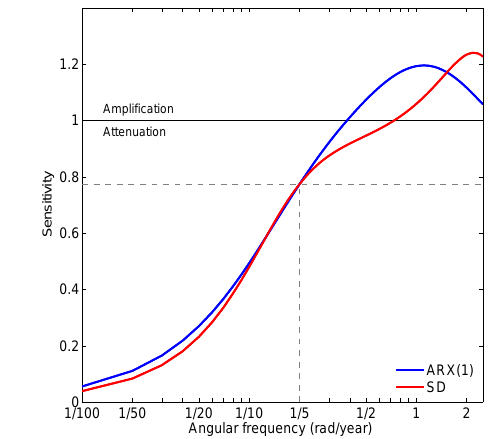
Figure 6. Magnitude of the sensitivity function S ( s ) = (1 + G ( s ) K ( s )) − 1 for the first-order linear model (ARX(1)) and semi-infinite diffusion model (SD). Model parameters are the same as in Figs. 4 and 5, and K ( s ) = 1.0 + 0.4 /s . Black horizontal line indicates || S ( s ) ||= 1; values above this line indicate amplification at that frequency, and values below this line indi- cate attenuation. Grey vertical line indicates the loop crossover frequency ω gc = 0.2radyr − 1 .